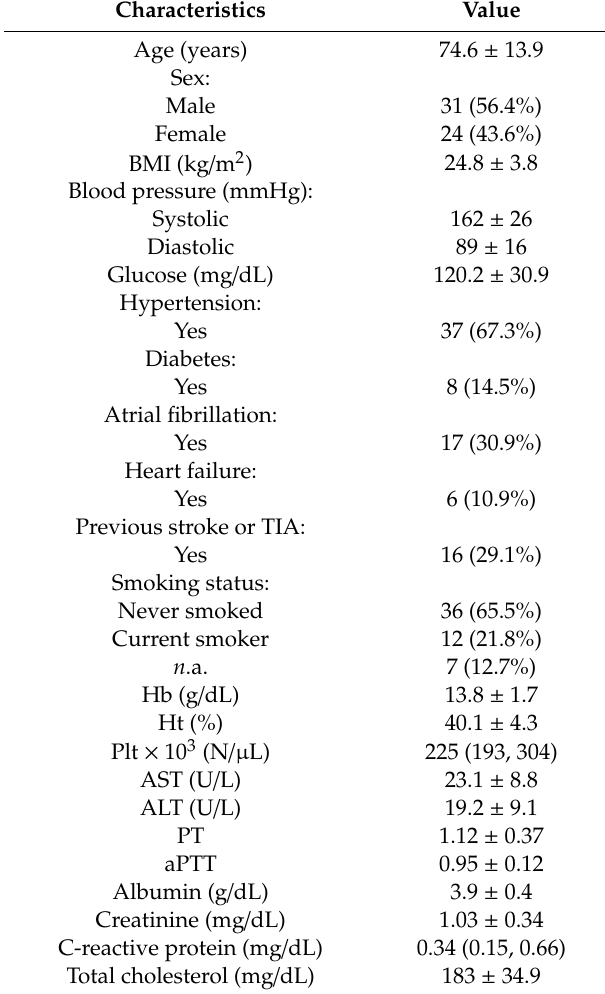
Table 1. Demographic and clinical characteristics of the studied population ( n =